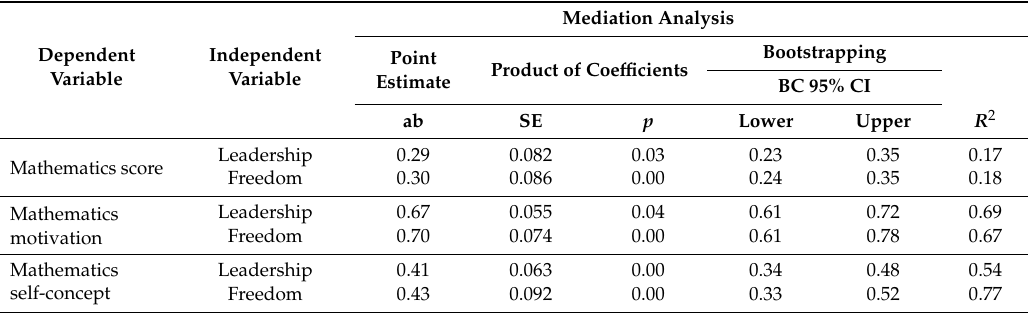
Table 2. The results of mediation